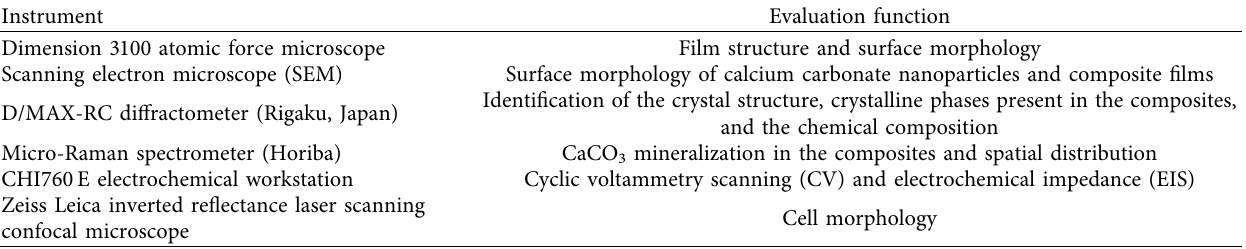
Table 2: Instruments used for characterization of the synthetic